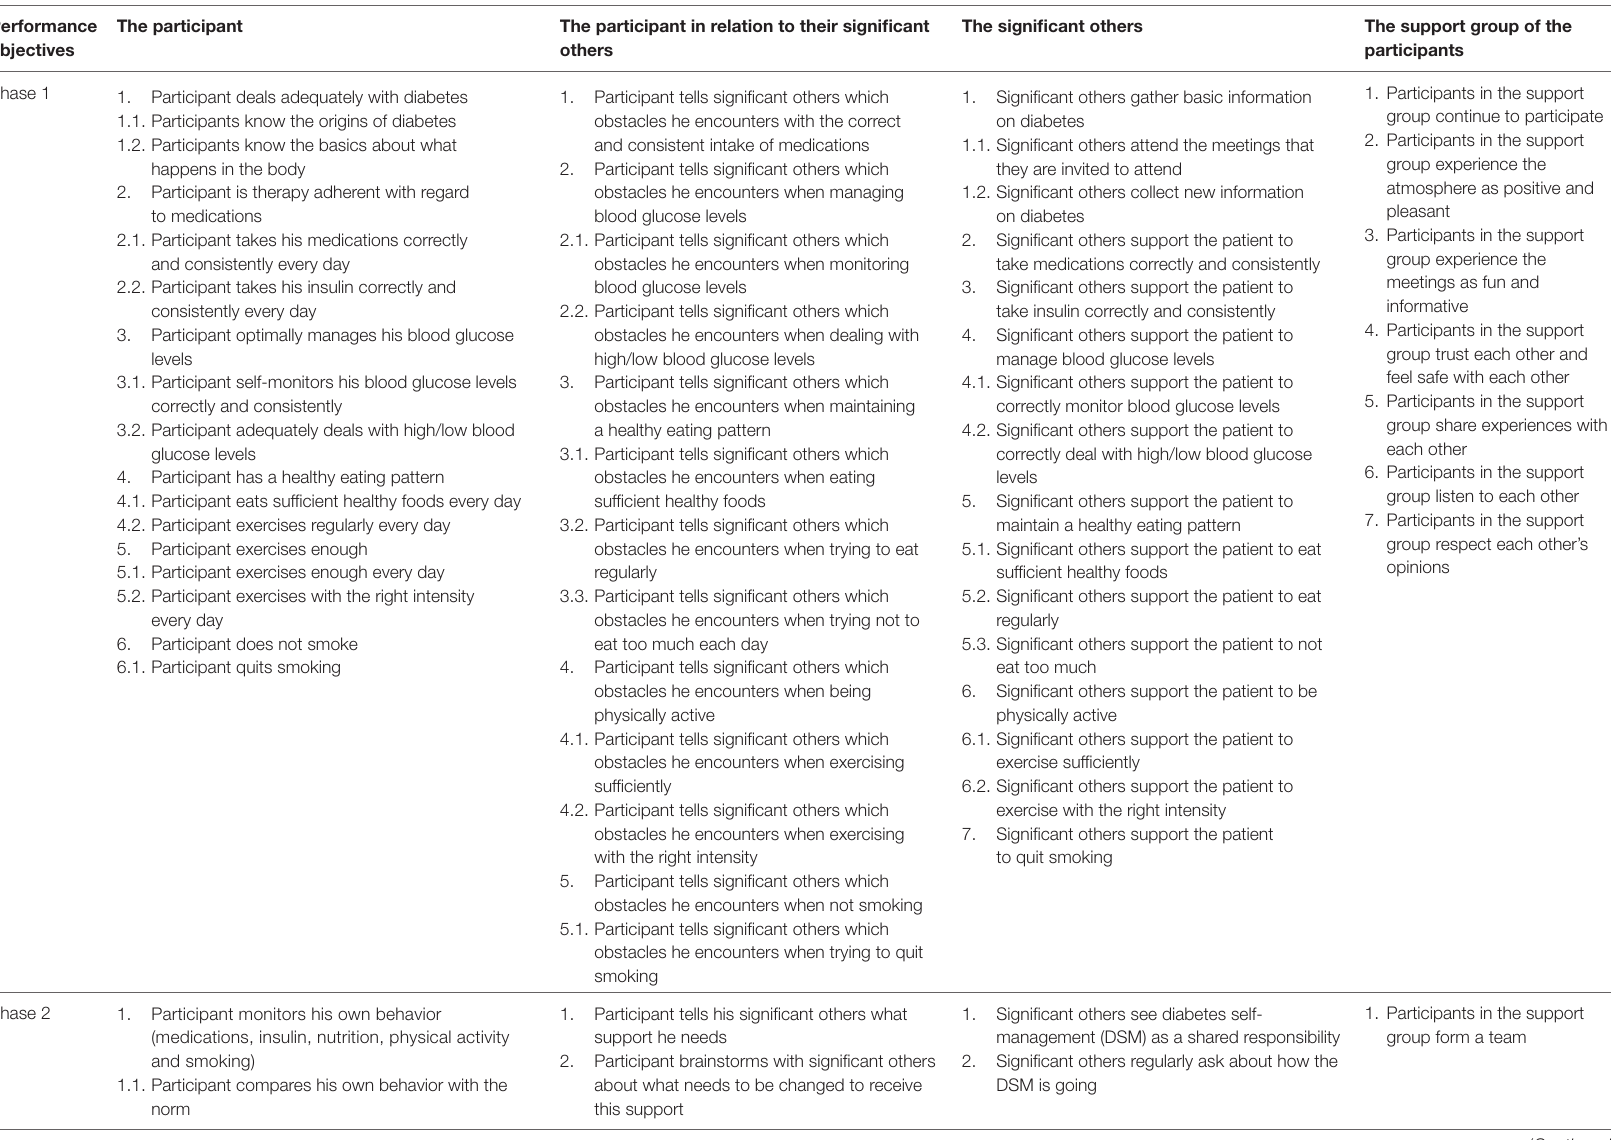
TaBle 7 | Performance and change objectives of the intervention Powerful Together with Diabetes . Performance